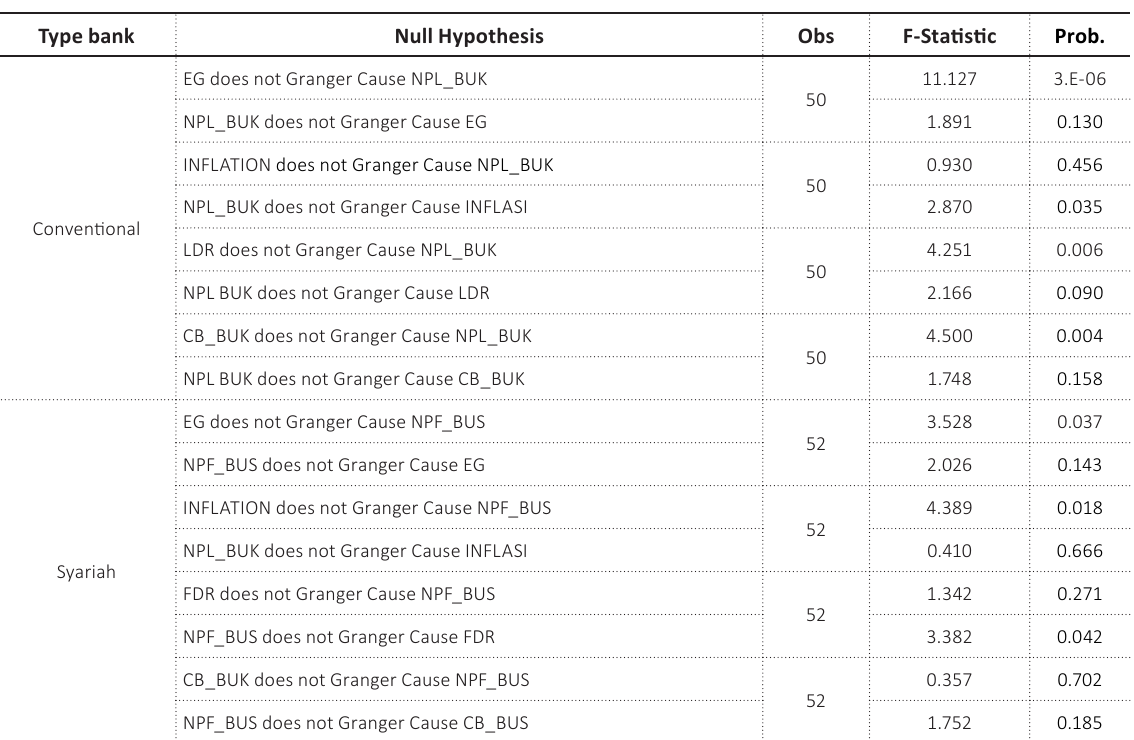
Table A5. Granger causality test